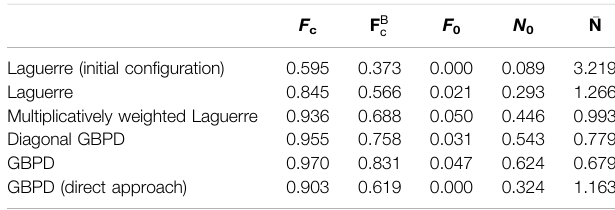
TABLE 3 | Values of performance measures for various tessellation models fi tted to the smoothed experimental image data.